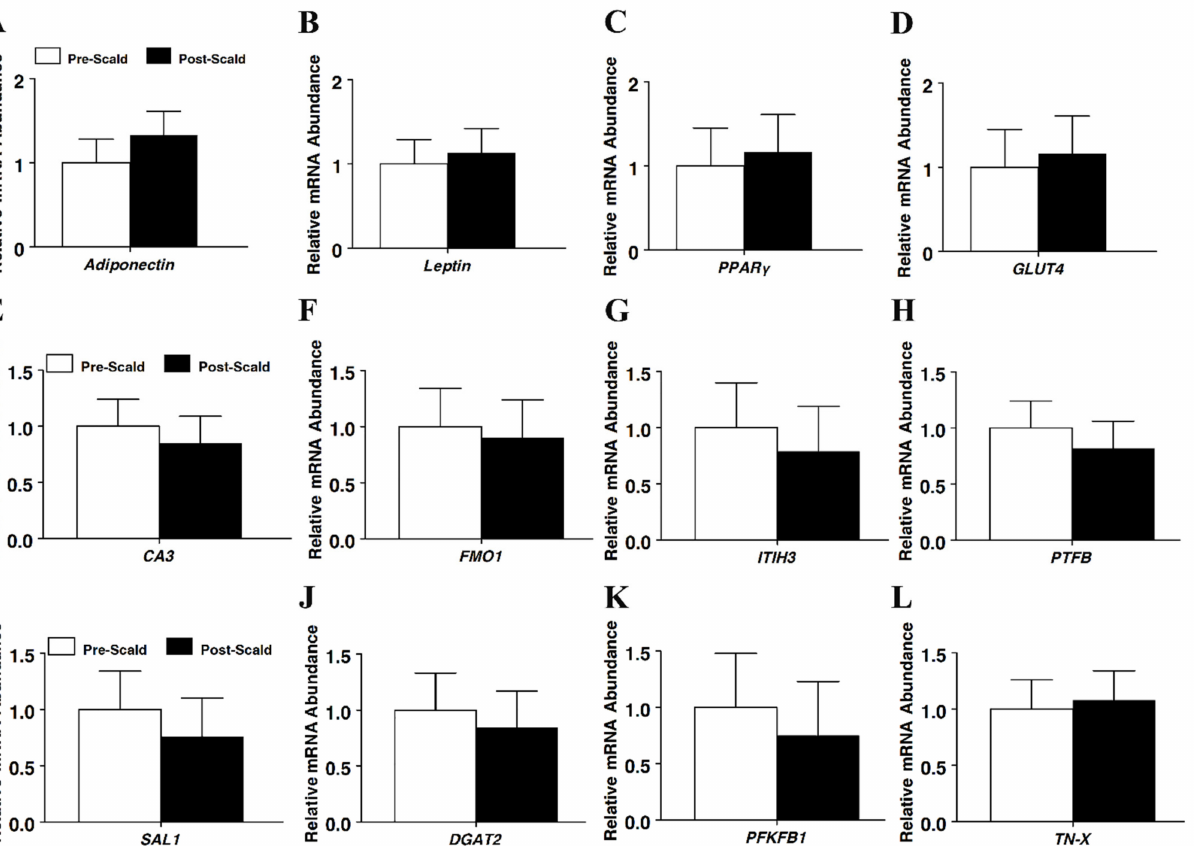
Figure 2. The effect of scalding on mRNA expression in subcutaneous adipose tissue of market weight hogs, as determined using real-time RT-PCR for genes ( A ) adiponectin, ( B ) leptin, ( C ) peroxisome proliferator-activated receptor gamma ( PPAR γ ), ( D ) glucose transporter 4 ( GLUT4 ), ( E ) carbonic anhydrase III ( CA3 ), ( F ) flavin-containing monooxygenase 1 ( FMO1 ), ( G ) inter-alpha (globulin) in- hibitor H3 ( ITIH3 ), ( H ) 6-phosphofructo-2-kinase/fructose-2,6-biphosphatase 1 ( PFKFB1 ), ( I ) salivary lipocalin ( SAL1 ) , ( J ) diacylglycerol O-acyltransferase 2 ( DGAT2 ), ( K ) pleiotropic factor beta ( PTF β ), and ( L ) tenascin-X ( TN-X ). Values were normalized to S15 mRNA abundance and expressed as a fold change relative to pre-scald samples and calculated according to Pfaffl (2010). Bars denoted by differ ( p < 0.05); pre-scald, n = 8; post-scald, n =